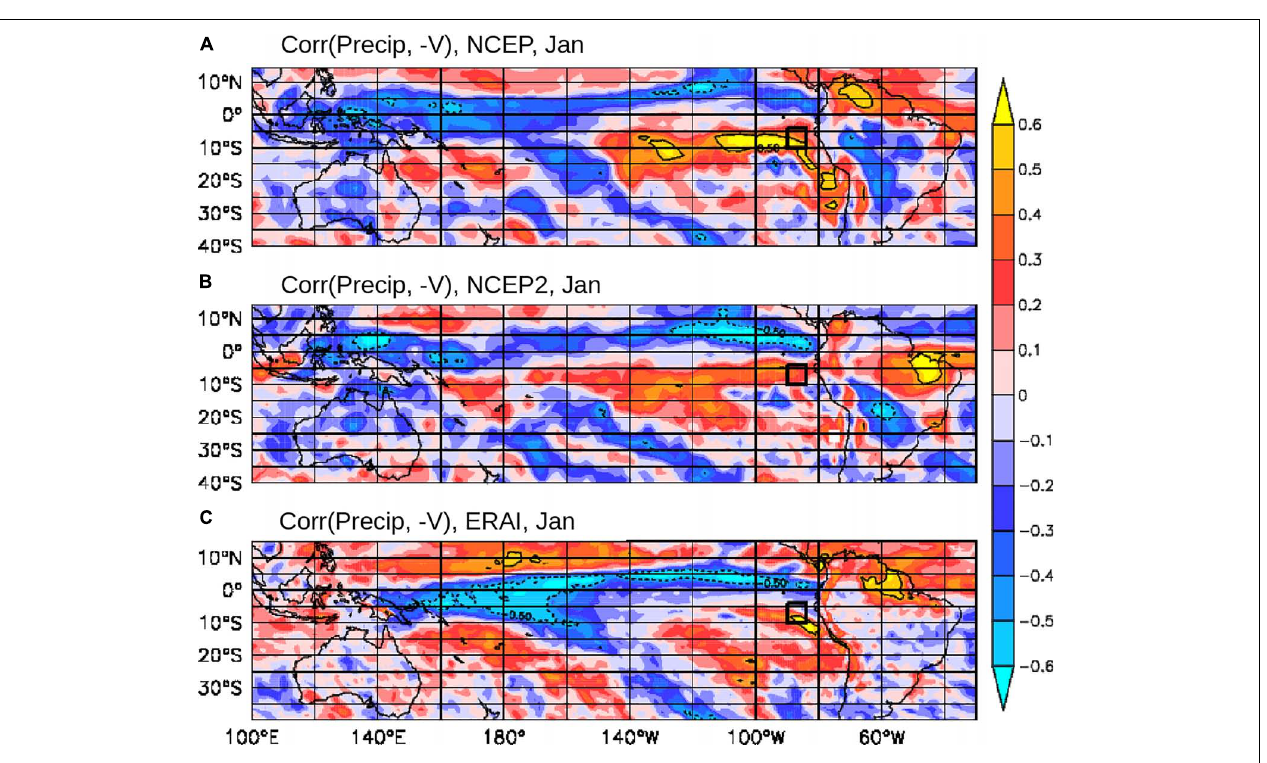
FIGURE 12 | Correlation between South and Equatorial Pacific monthly precipitation and meridional wind (positive when oriented poleward, averaged in black square) in the far-eastern Pacific in January. The correlations were computed from three different reanalyses products: (A) NCEP, (B) NCEP2, and (C) ERAI. Monthly anomalies were computed over 1979–2016. Full and dashed contours mark correlations of 0.5 and –0.5,